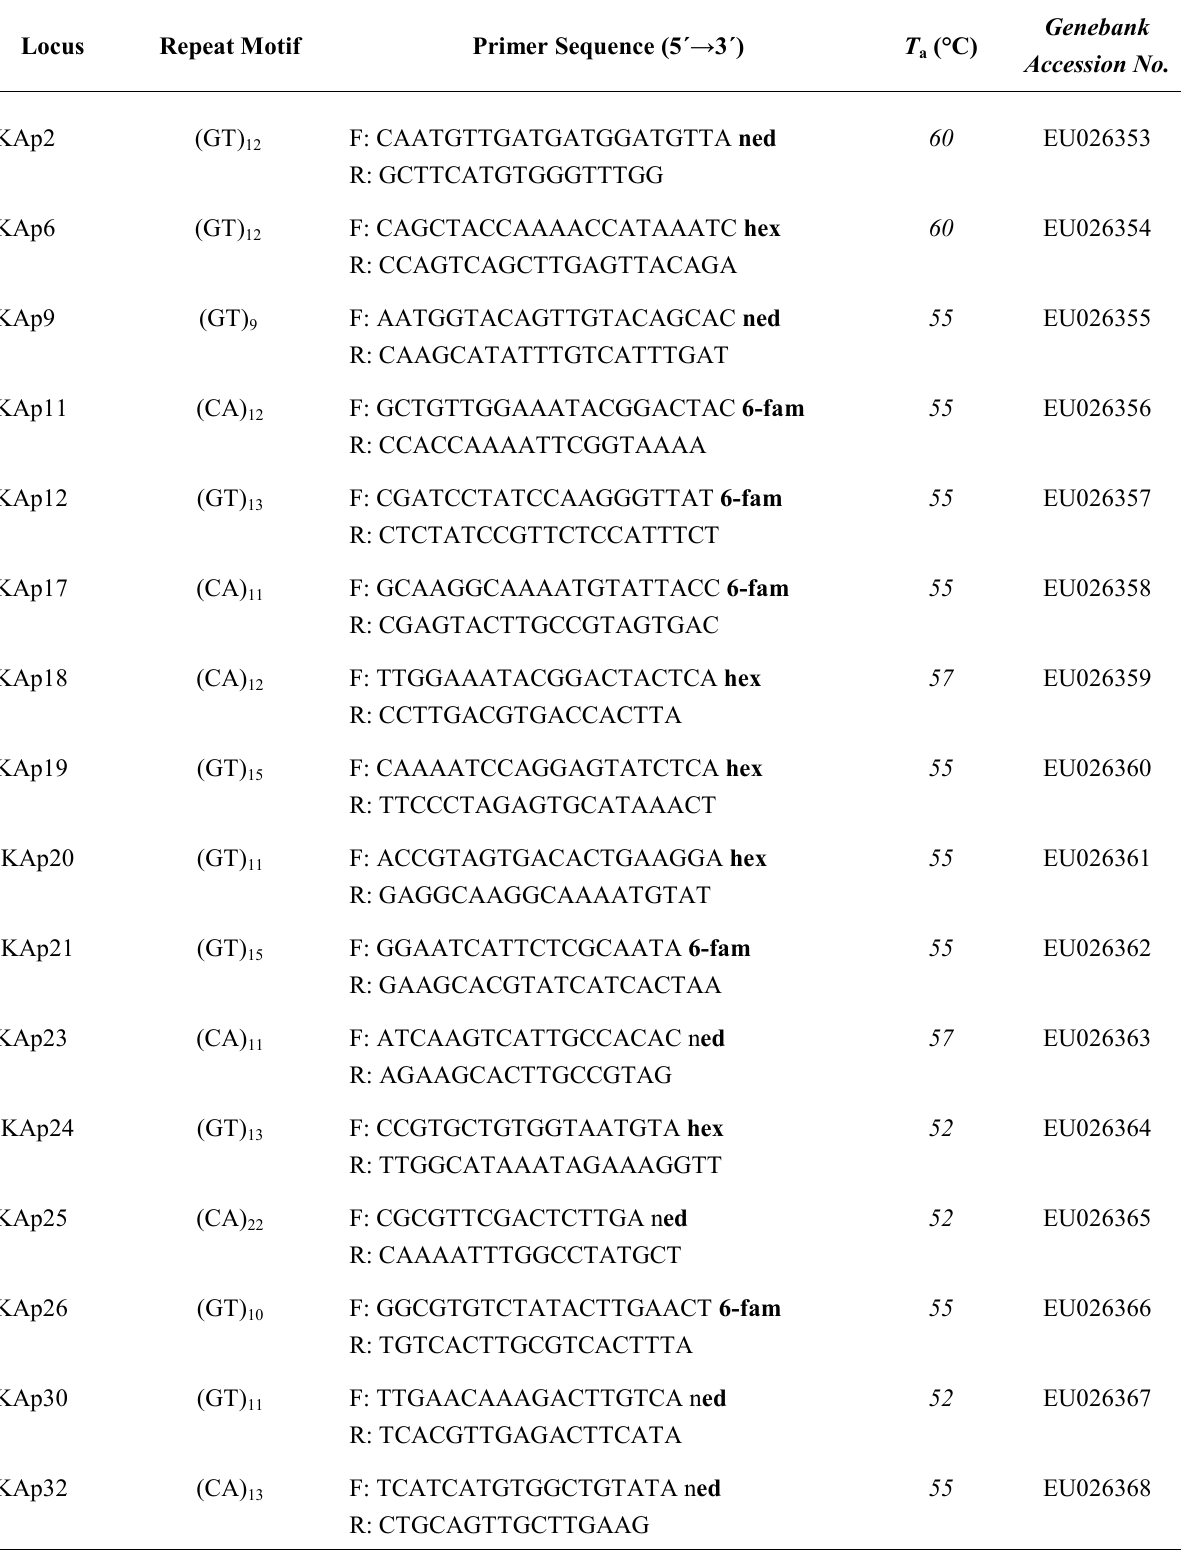
Table 1. Characteristics of the 21 microsatellite loci isolated from Atrina pectinata .